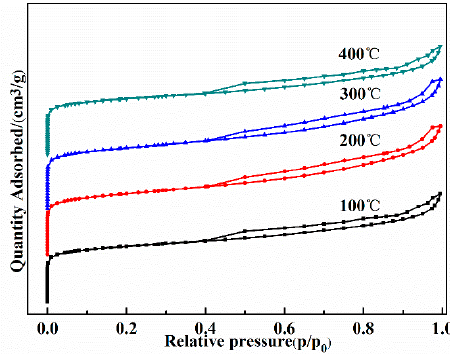
Figure 1. N 2 adsorption–desorption isotherms for 10 wt% NiP/H β calcined at different temperatures.